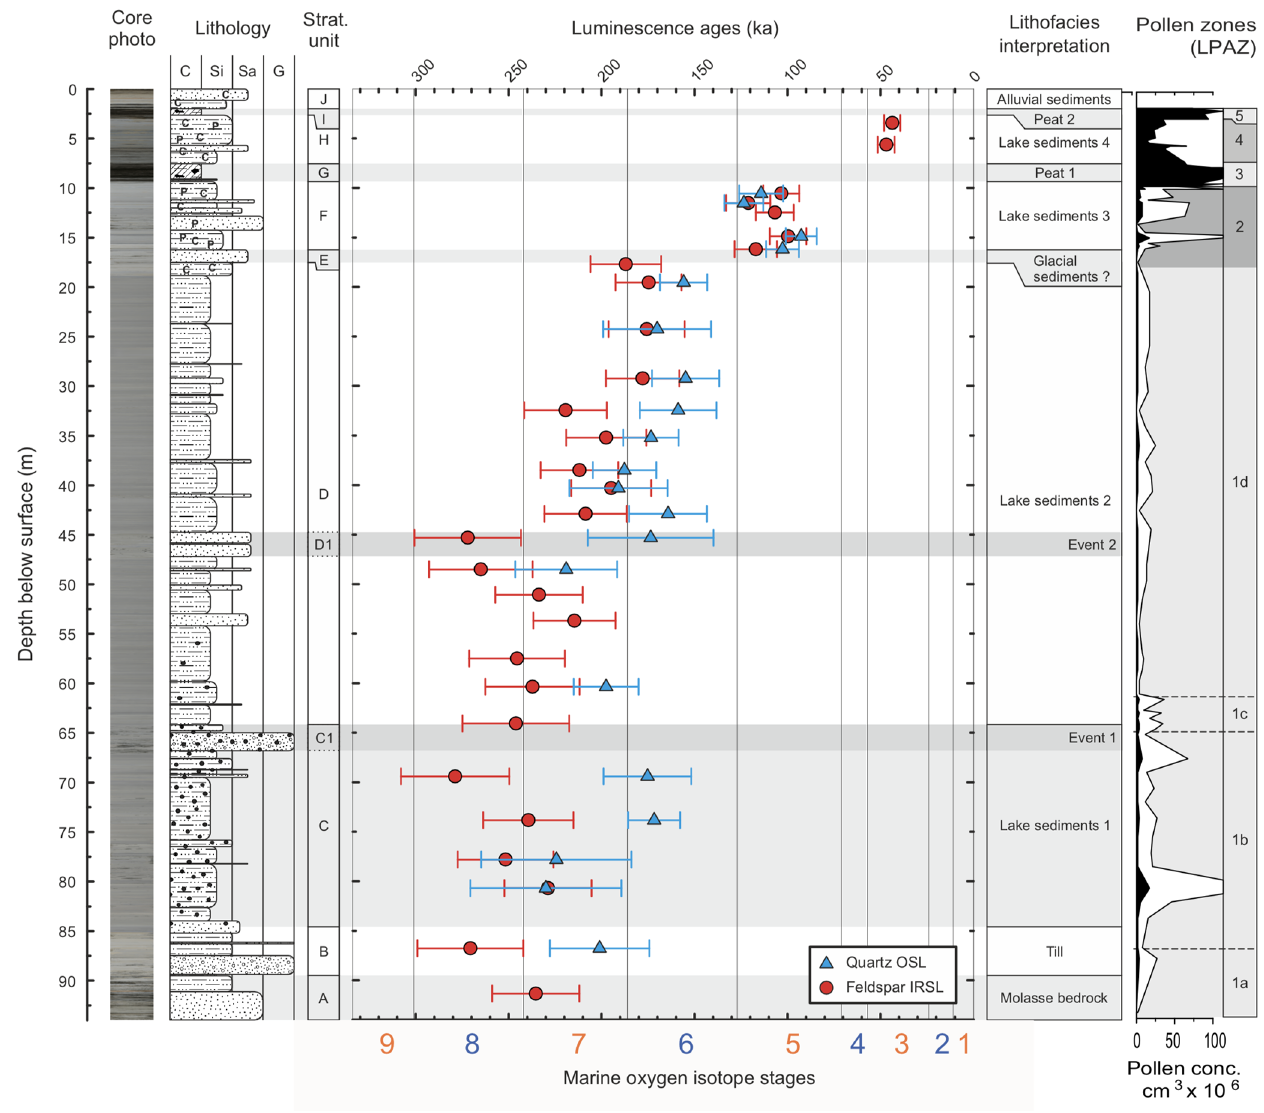
Figure 4. Core photograph, grain-size coded stratigraphic column, geochronology, and interpretation of depositional environment of the Niederweningen site (modified after Dehnert et al., 2012) with indicated marine isotope stages at the bottom (Bassinot et al., 1994) and lithofacies interpretation of the stratigraphic units. Pollen concentration data are shown on the right: white areas represent exaggeration × 10 of the pollen concentration curve. LPAZ indicates local pollen assemblage zones: LPAZ 1 – reworked pollen; LPAZ 2 – Alpine meadow, initial phase of Late Glacial reforestation; LPAZ 3 – Eemian or second Early Würmian interstadial; LPAZ 4 – increasingly inundated by water; LPAZ 5: very wet Cyperaceae/moss